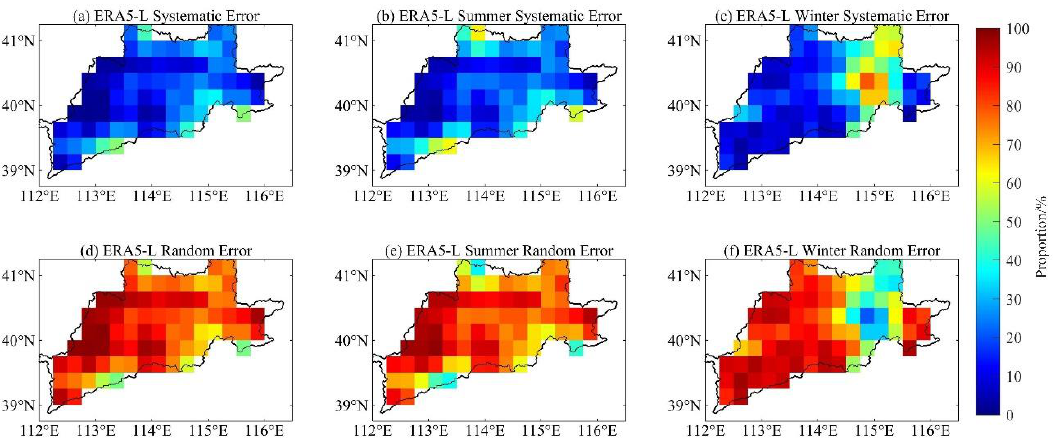
Figure 3. ( a – f ) Systematic and random error components (%) of the ERA5-Land reanalysis precipi- tation dataset.